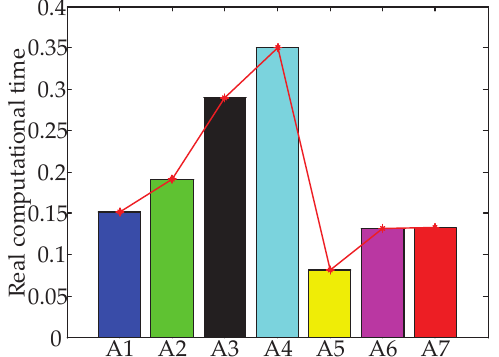
Figure 6. Real computational time of f 11 in 50